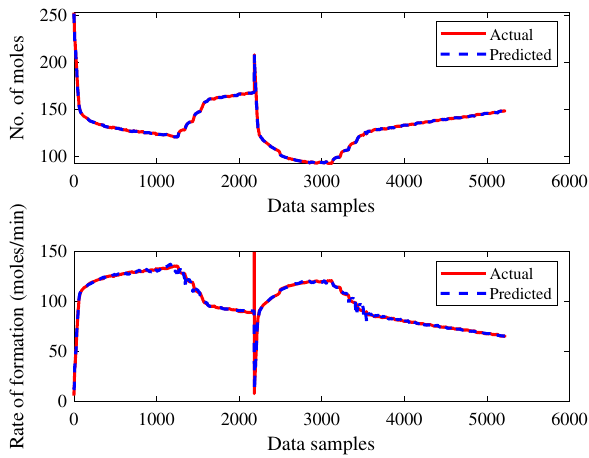
Figure 11. ANN training performance for gas + CO 2 .